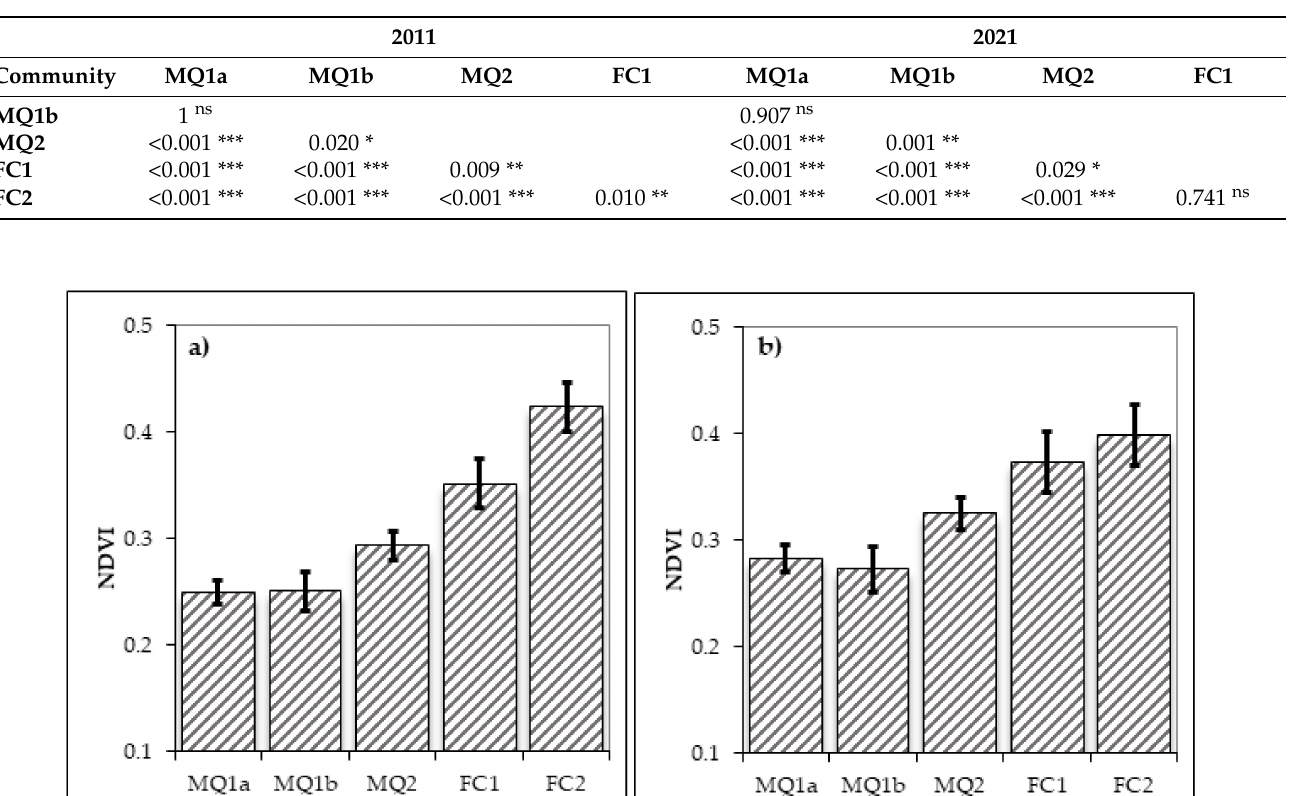
Table 7. Post Hoc pair-wise comparisons on the NDVI differences between the communities for August 2011 and July 2021. ns = Not significant, * = Significant, ** = Very significant, *** = Extremely significant.